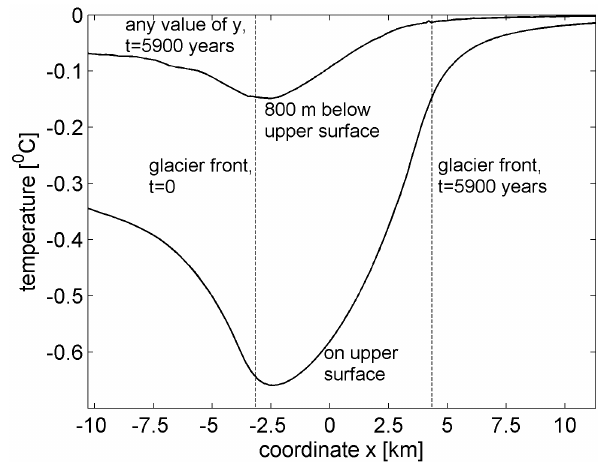
Figure 19. Variation of the mean effective stress [Pa] in the in- tact part of the rock mass with fracture zones in the cross sec- tions y = 6200 and − 3200m, corresponding to the fractured and homogeneous regions, respectively, at a depth of 200m and at time 5900